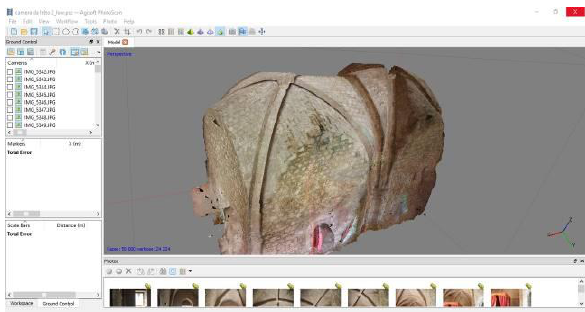
Figure 7. An example of a 3D model of an indoor environment of the castle obtained from the photogrammetric reconstruction